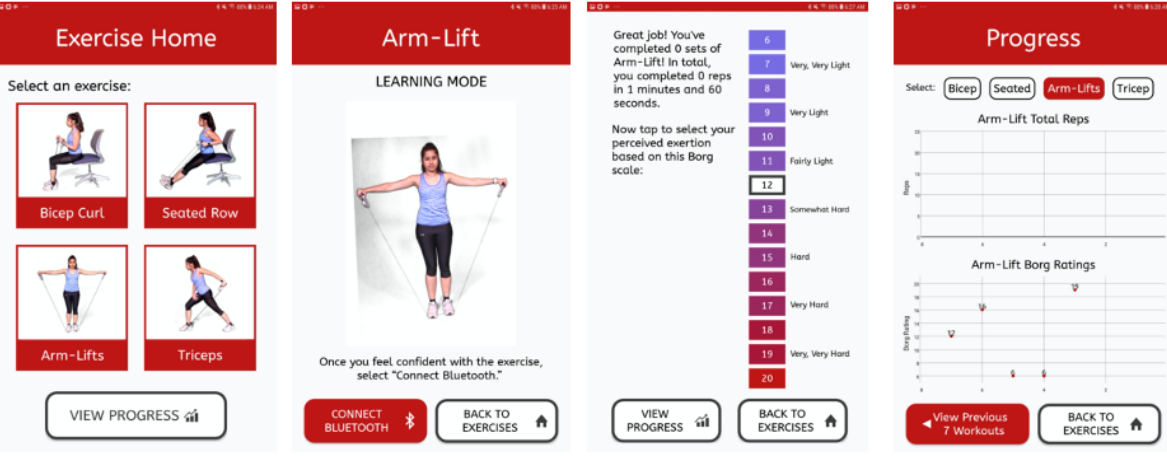
Figure 3. The app versions for round 3 screens were in color, had the embedded video with a low-contrast background. Here, we present the home screen, the preworkout screen, the workout screen, the Borg Scale of Perceived Exertion questionnaire, and the progress